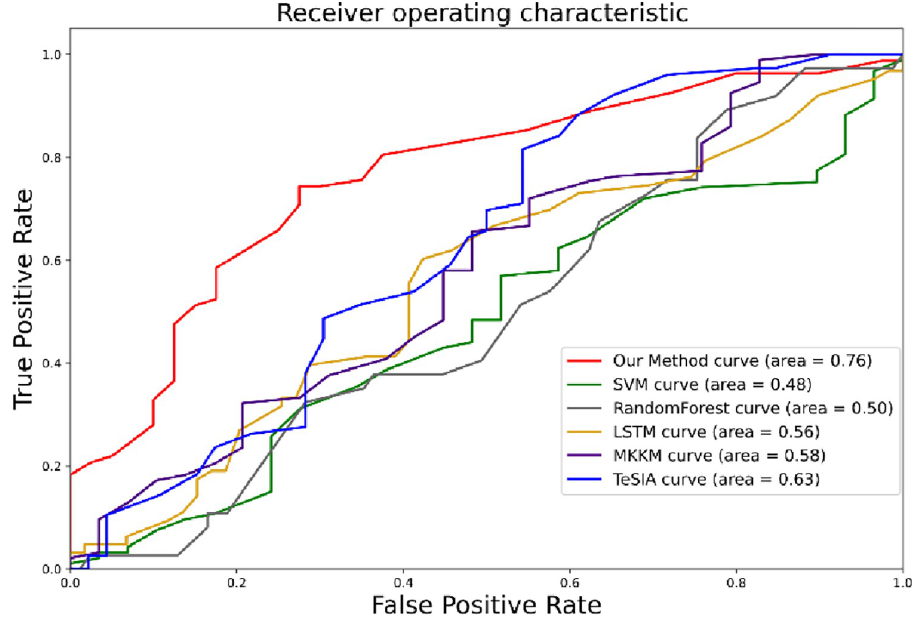
Fig 9. ROC/AUC plot for predicting the classification of 300 CSI